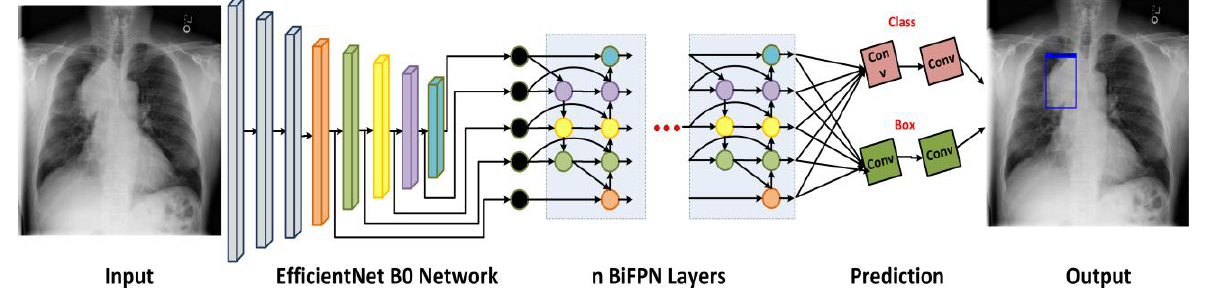
Figure 1. Pictorial description showing the basic flow of the proposed work. Algorithm 1: Infected Region Detection